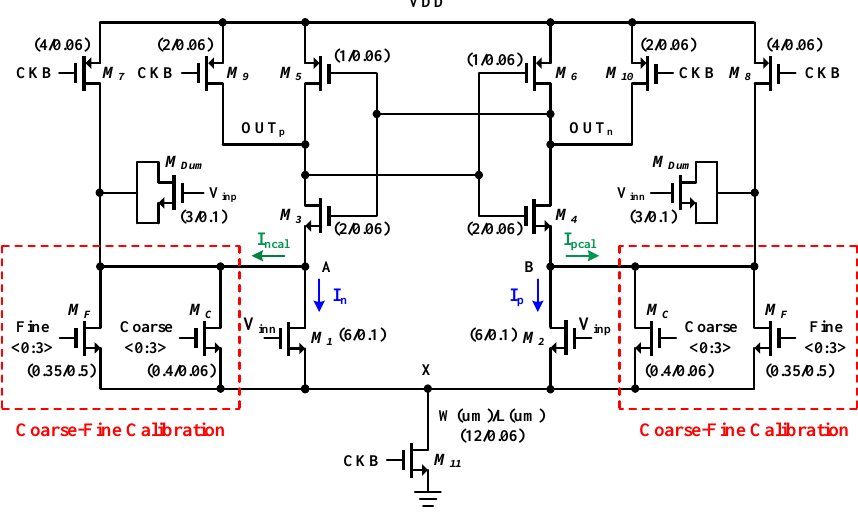
Figure 8. Schematic of the differential comparator with offset calibration transistors.